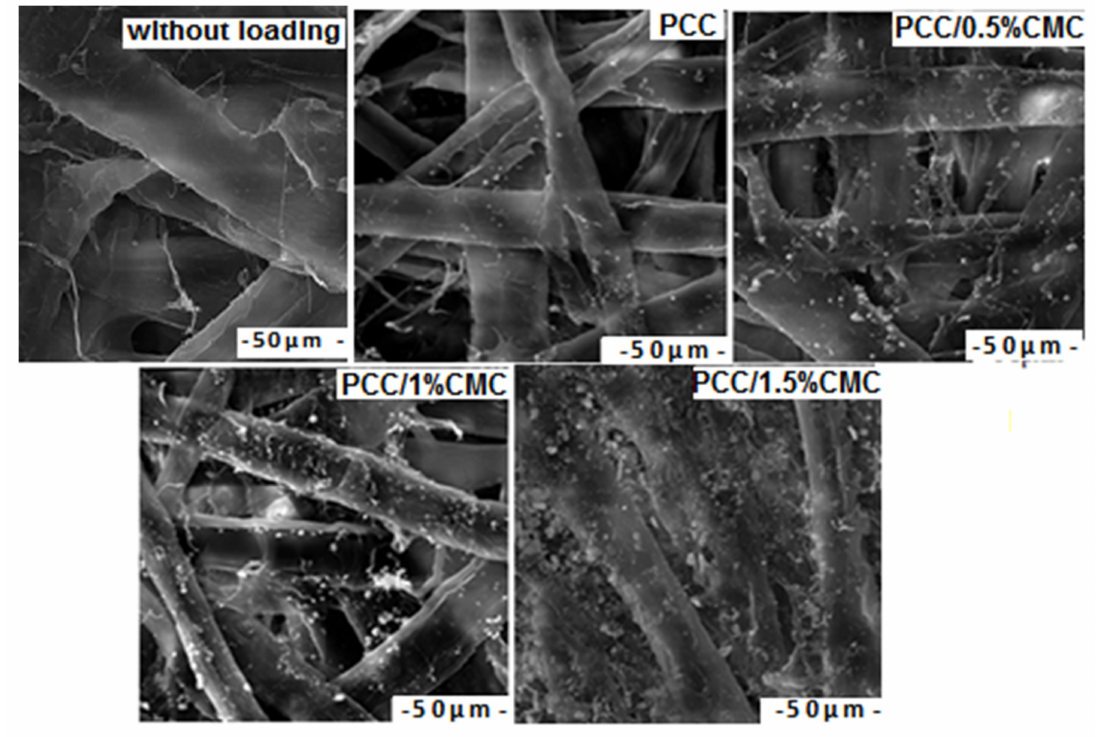
Figure 7. SEM micrographs for paper samples.